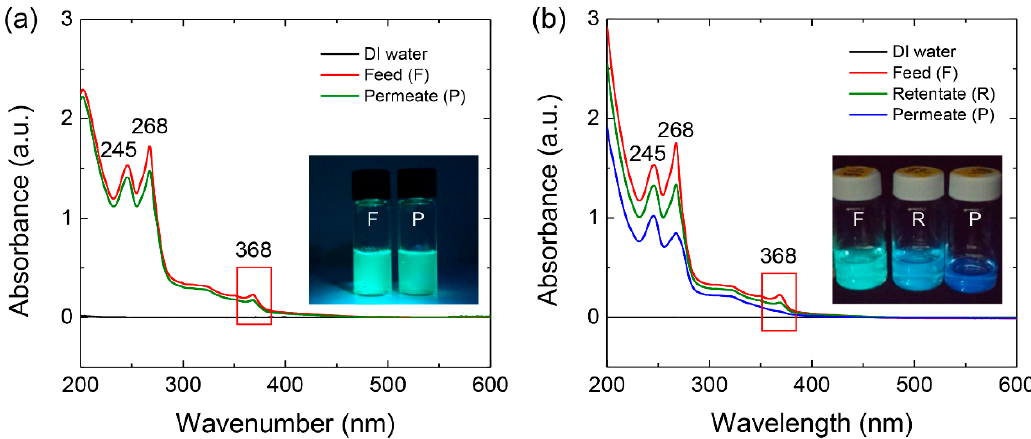
Figure 5. Absorbance spectra of GQD solutions before and after applying the two filtration modes. ( a ) Dead-end filtration and ( b ) cross-flow filtration (Inset: Photographs of the GQD solutions taken under illumination with 365 nm light).